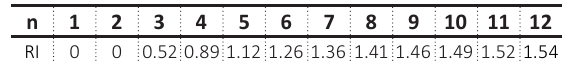
Table 4. Average random consistency index RI